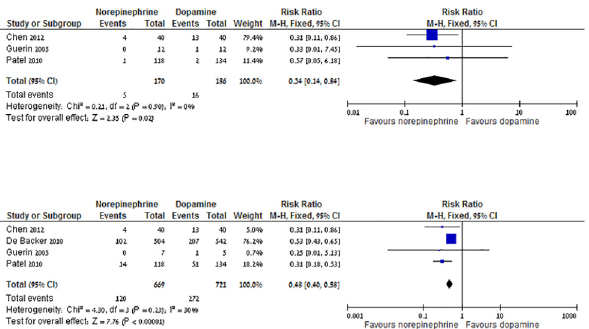
Fig 4. a. Norepinephrine versus dopamine, major adverse events. b. Norepinephrine versus dopamine, cardiac